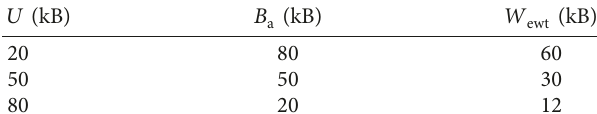
Table 1: W in function of the occupation level U . ewt